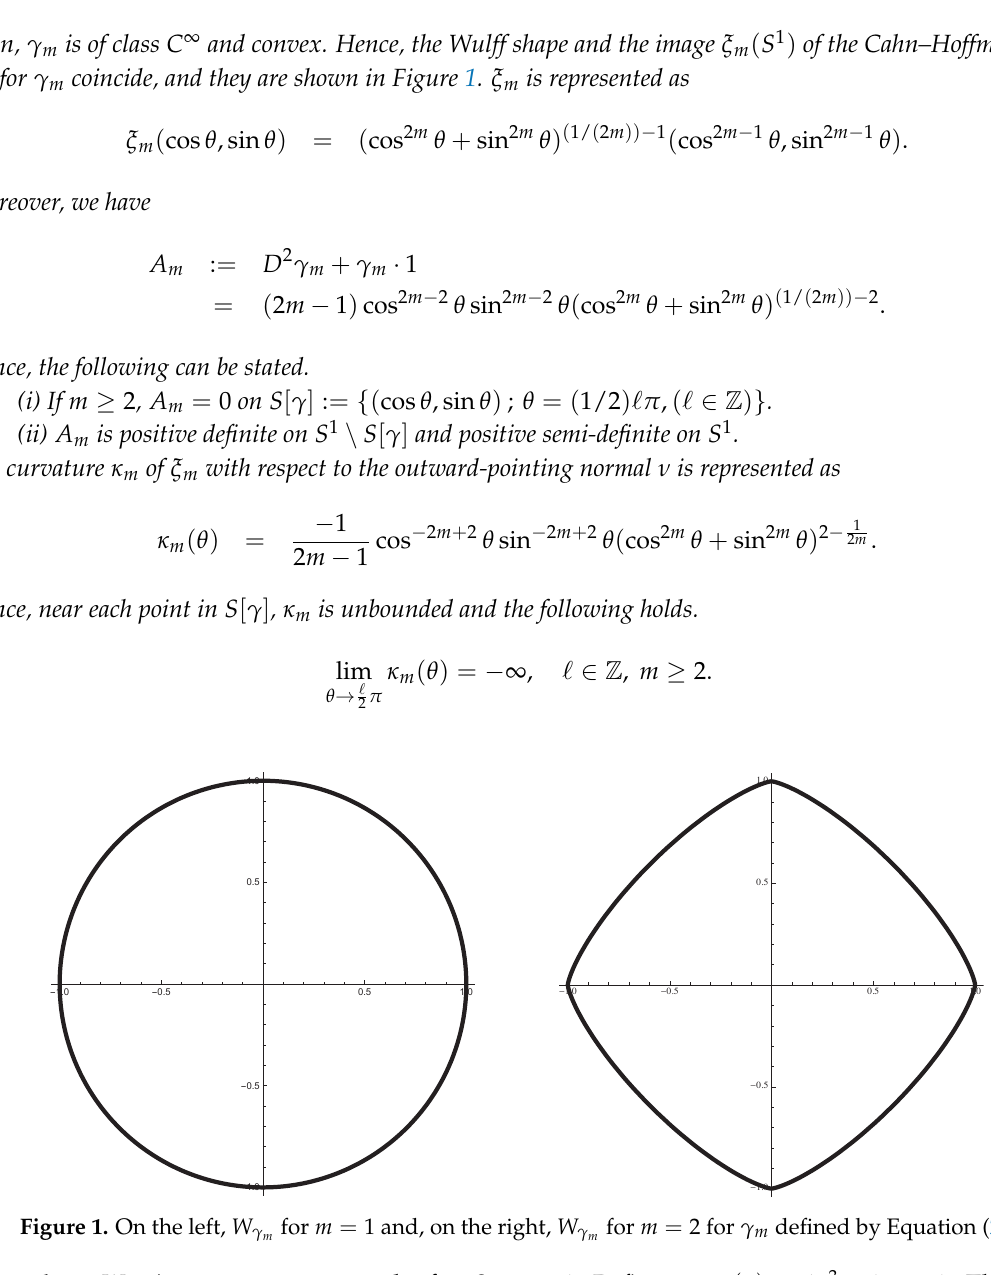
for m = 1 and, on the right, W γ m